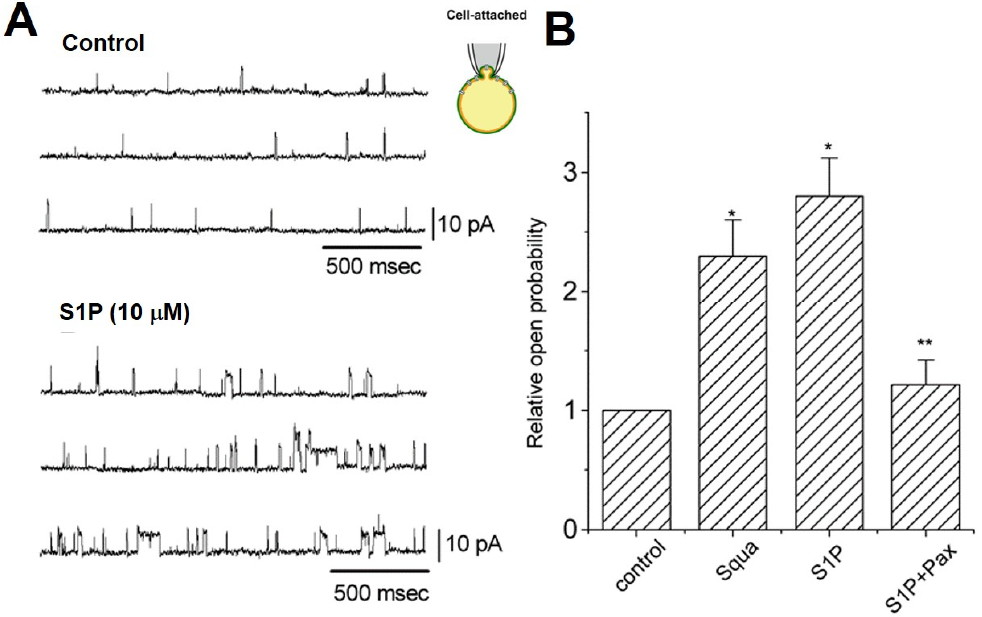
Figure 7. S1P-induced BK Ca activation in the cell-attached configuration of PC12 cells. ( A ) The cells were bathed in a high-K + bathing solution with 1.8 mM CaCl 2 , holding at +60 mV. The original current traces were obtained in the control and 3 min after the S1P (10 µM) application. ( B ) Summary of the effects of squamocin (Squa, 10 µM), S1P, and S1P combined with paxilline (Pax, 1 µM) on the BK Ca open probability. The BK Ca activity in the control was considered to be 1.0 and the relative open probability by each agent was plotted. Asterisks indicate significant differences ( p < 0.05, * control, and ** S1P alone group, n = 5 − 9, in three cultures).